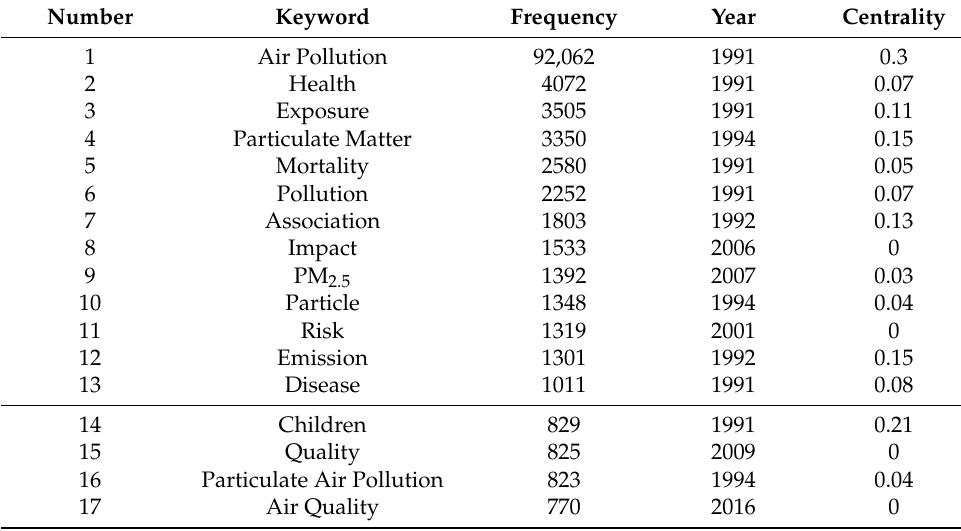
Table 2. Main research hot topics in this field in English literature.